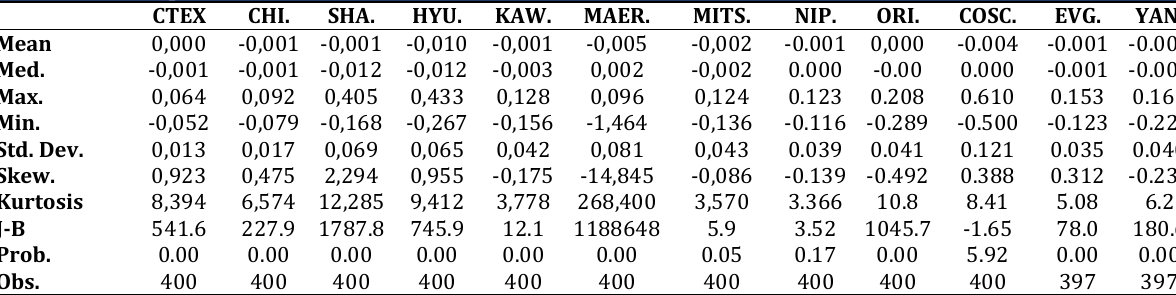
Table 2: Descriptive statistics of the return